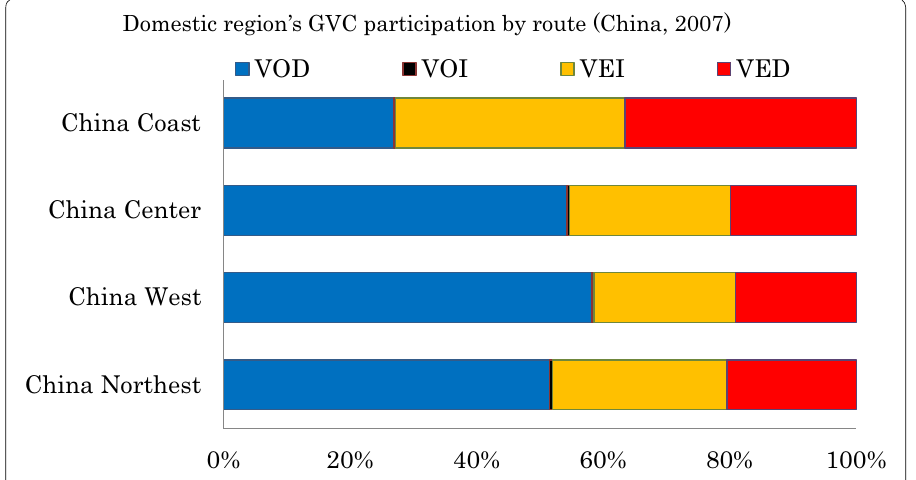
Fig. 5 Domestic region’s GVC participation by route (China 2007). VOD: regional value-added outflow through the pure domestic segment of GVCs. VOI: regional value-added outflow through the pure interna- tional segment of GVCs. VEI: Regional value-added exports through the pure domestic segment of GVCs. VED: regional value-added exports through the pure international segment of